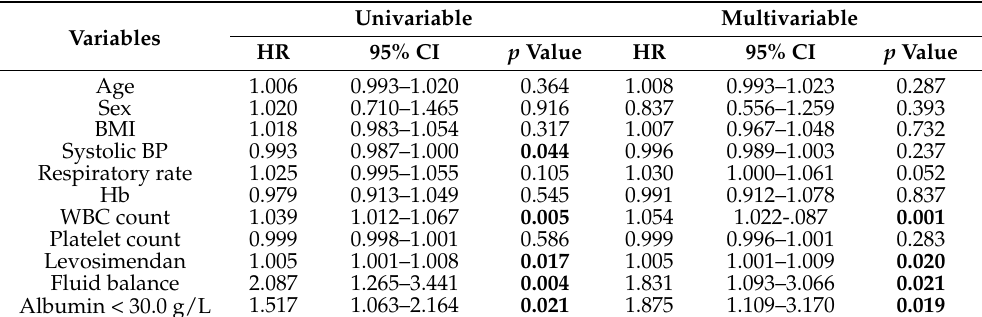
Table 5. Uni- and multivariable Cox regression analyses with regard to 30-day all-cause mortality within the entire study cohort.